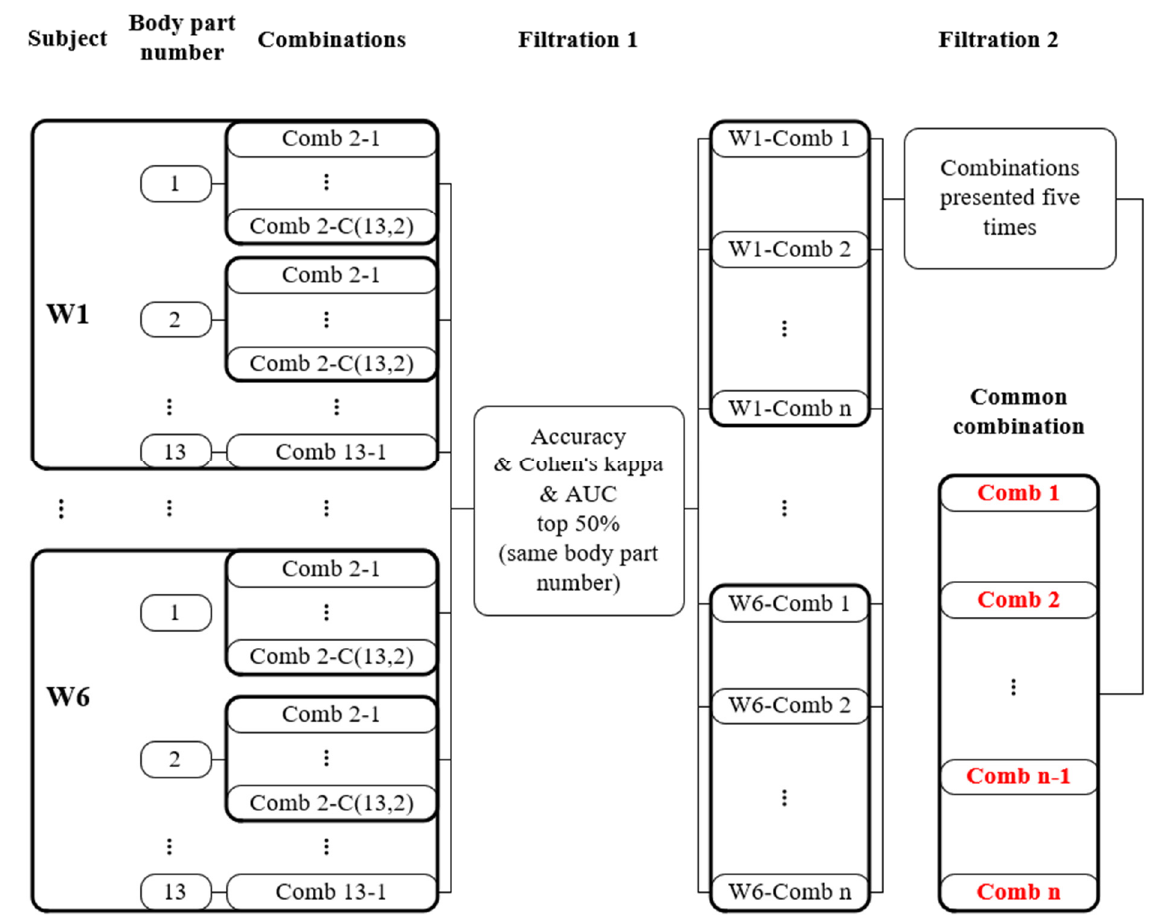
Figure 4. The method of selection for the common combinations .